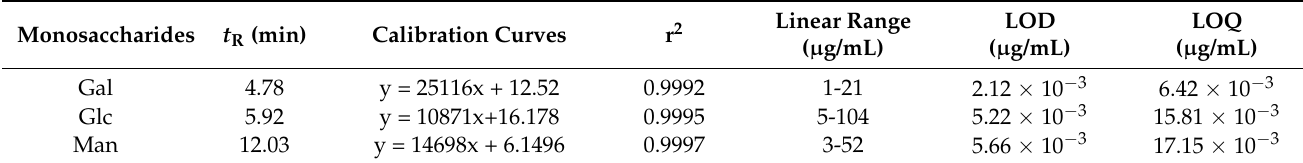
Table 4. Linearity, regression line, and LOD of the derivatives in the method.